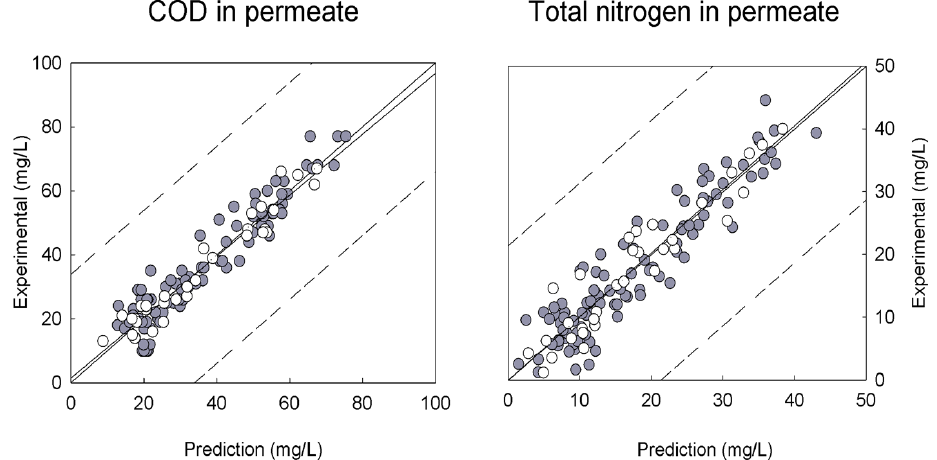
Figure 4. Fitting plots of experimental versus modeled COD and nitrogen concentrations in the permeate of an MBR. The training dataset is represented as gray circles, and the validation dataset used in PLS modeling is represented as open circles.